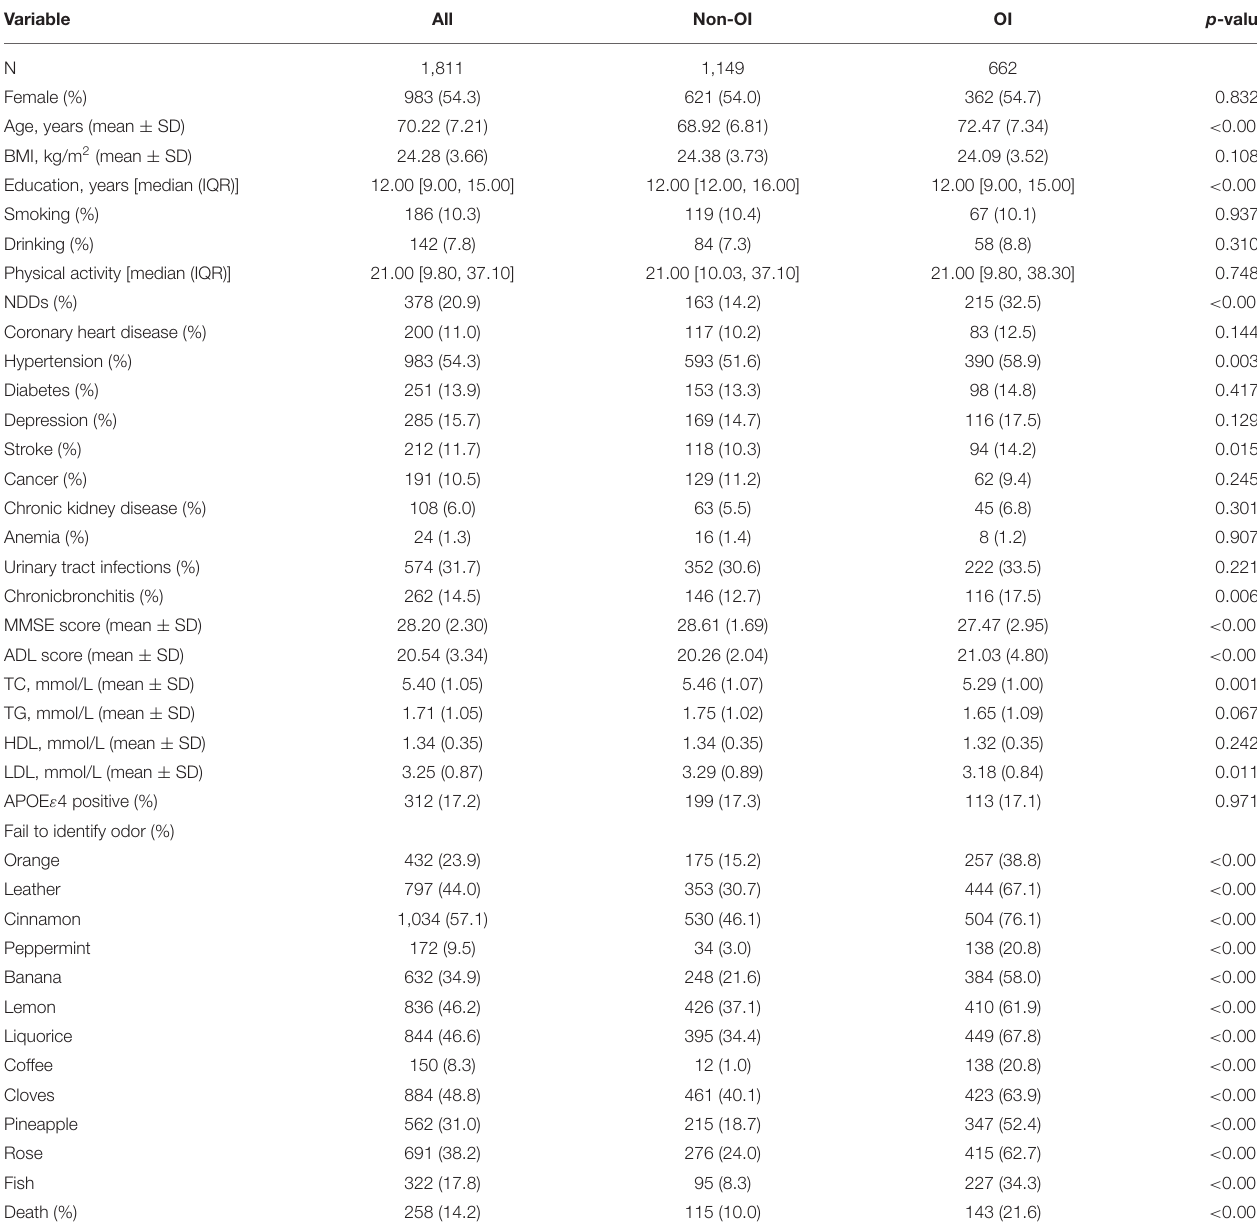
TABLE 1 | Baseline characteristics of the participants and follow-up outcomes.